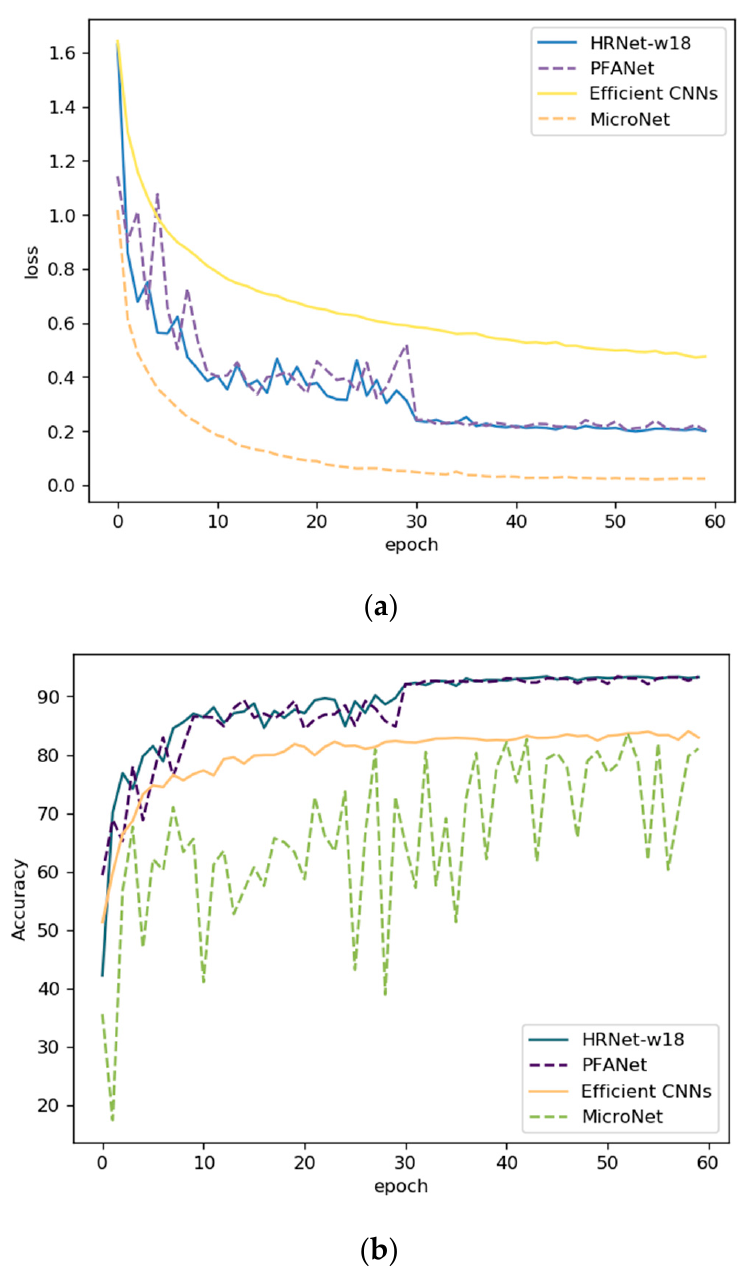
Figure 9. ( a ) The Training Loss curves on ITSRB. ( b ) The Training Accuracy curves on ITSRB.